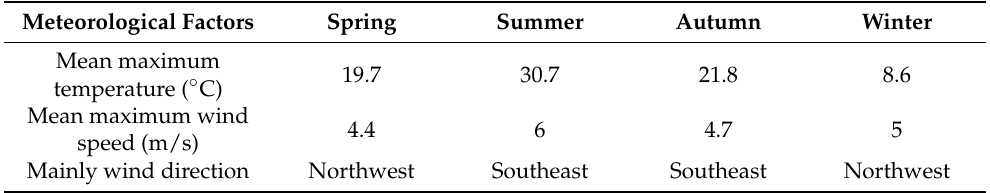
Figure 4. Temporal variations in wind frequency and temperature around the library in spring ( a ), summer ( b ), autumn ( c ), and winter ( d ). Table 6. Characteristics of temperature and wind around the library across the four